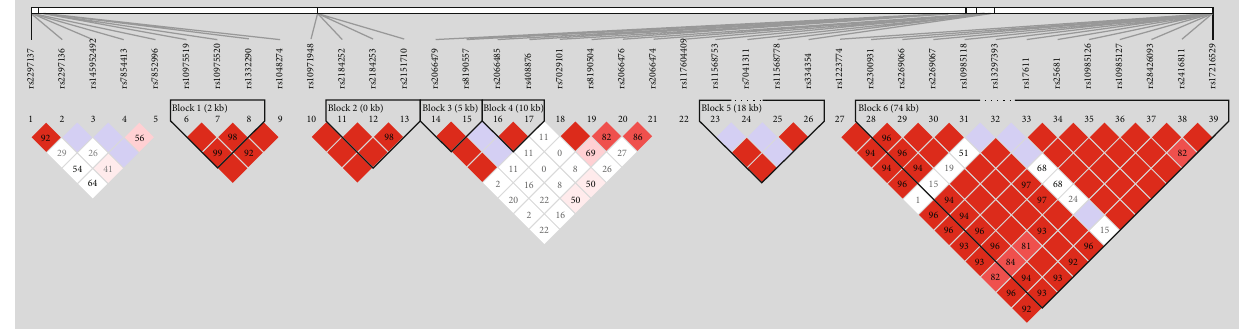
Figure 2: Linkage disequilibrium plot of SNPs in the detected genes. Among these, three IL-33-related SNPs had strong correlations: rs10975519, rs10975520, and rs1332290. Abbreviation: SNPs: single nucleotide polymorphisms.